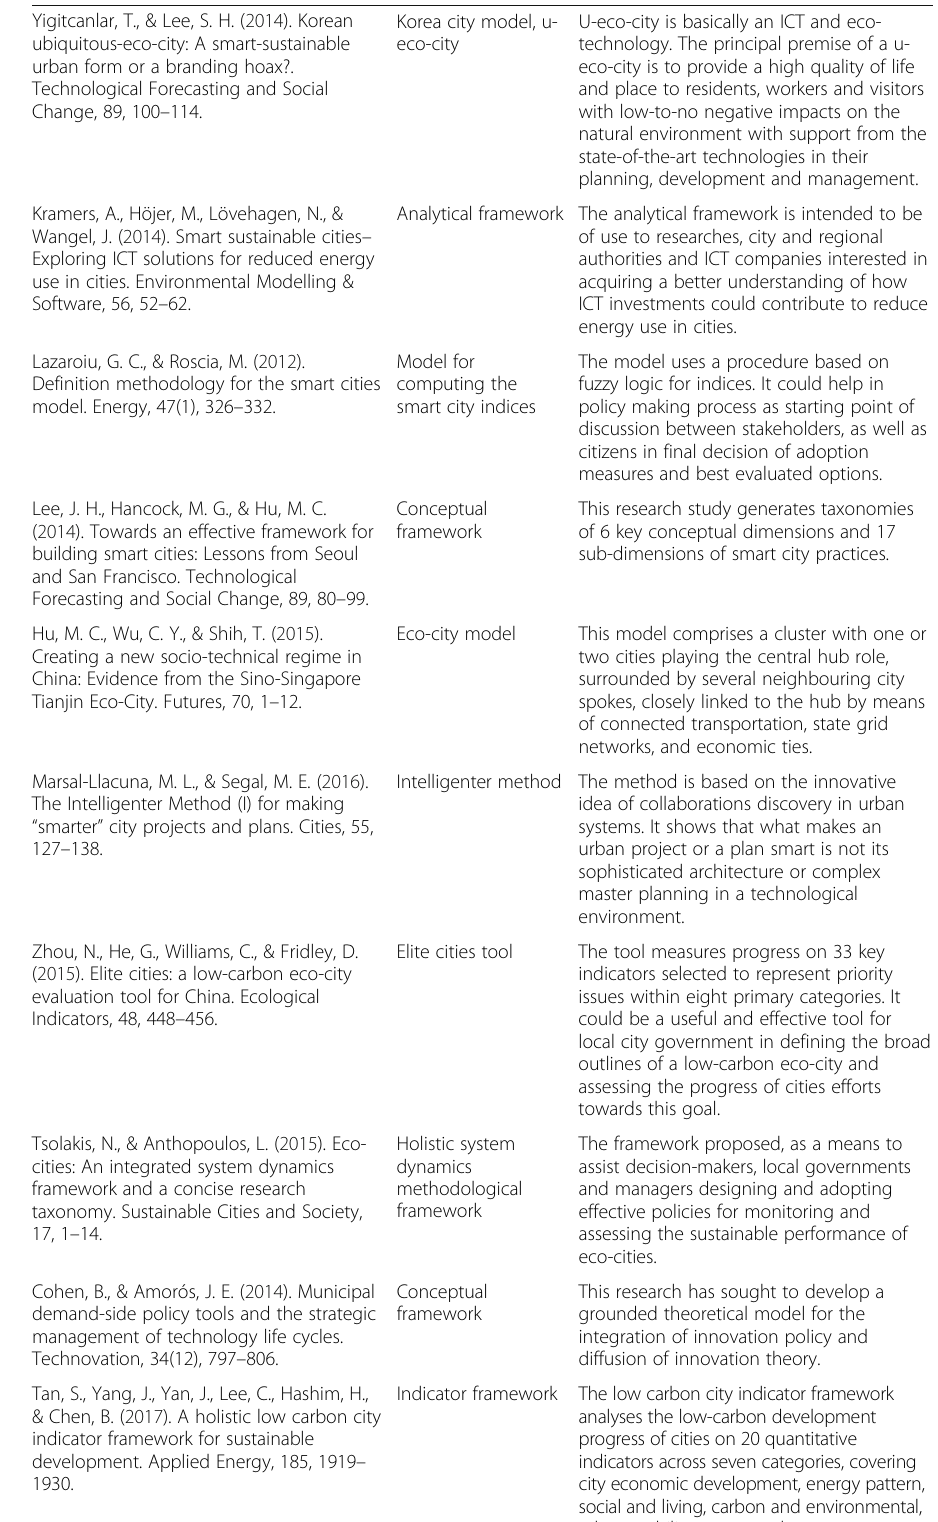
Table 2 Models, frameworks and